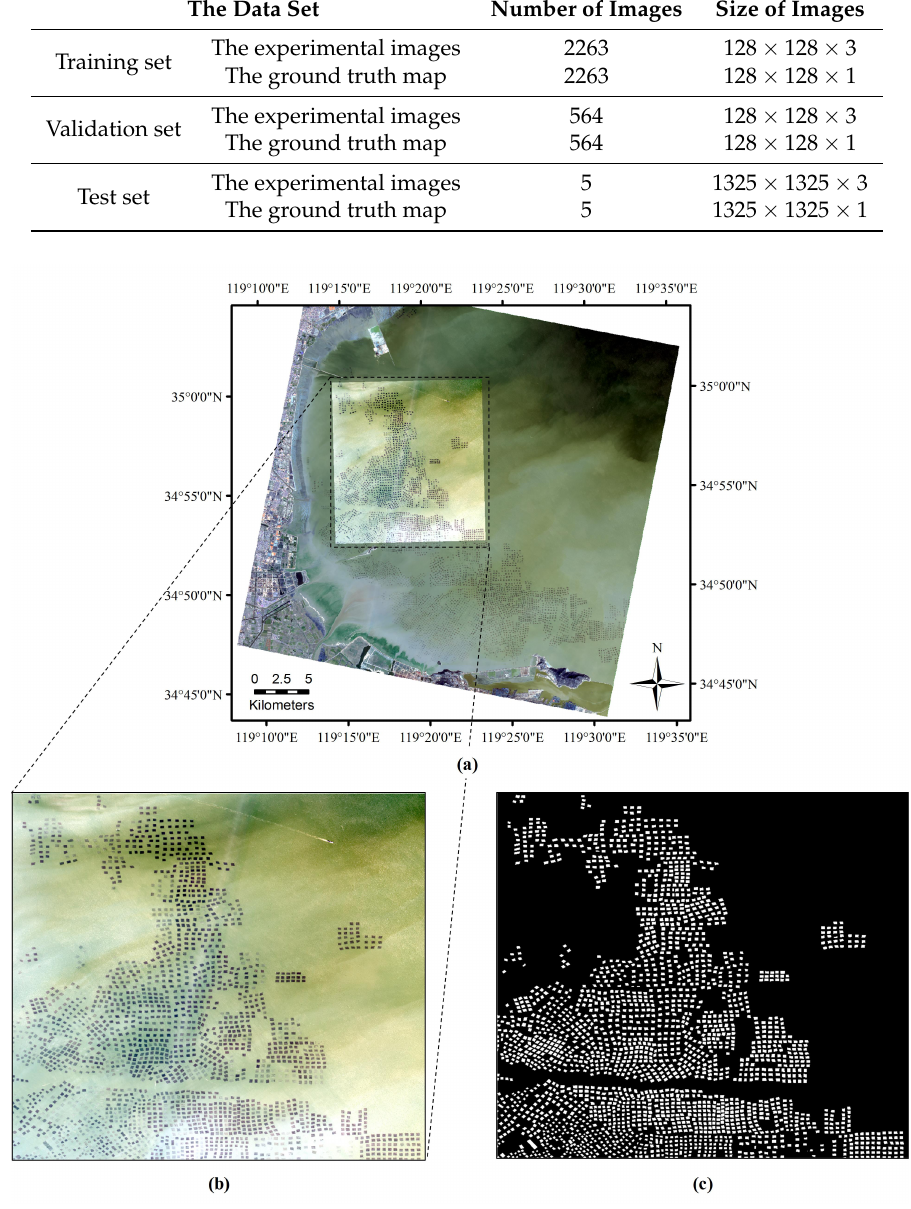
Figure 7. ( a ) Experimental area; ( b ) Experimental image; ( c ) Ground truth